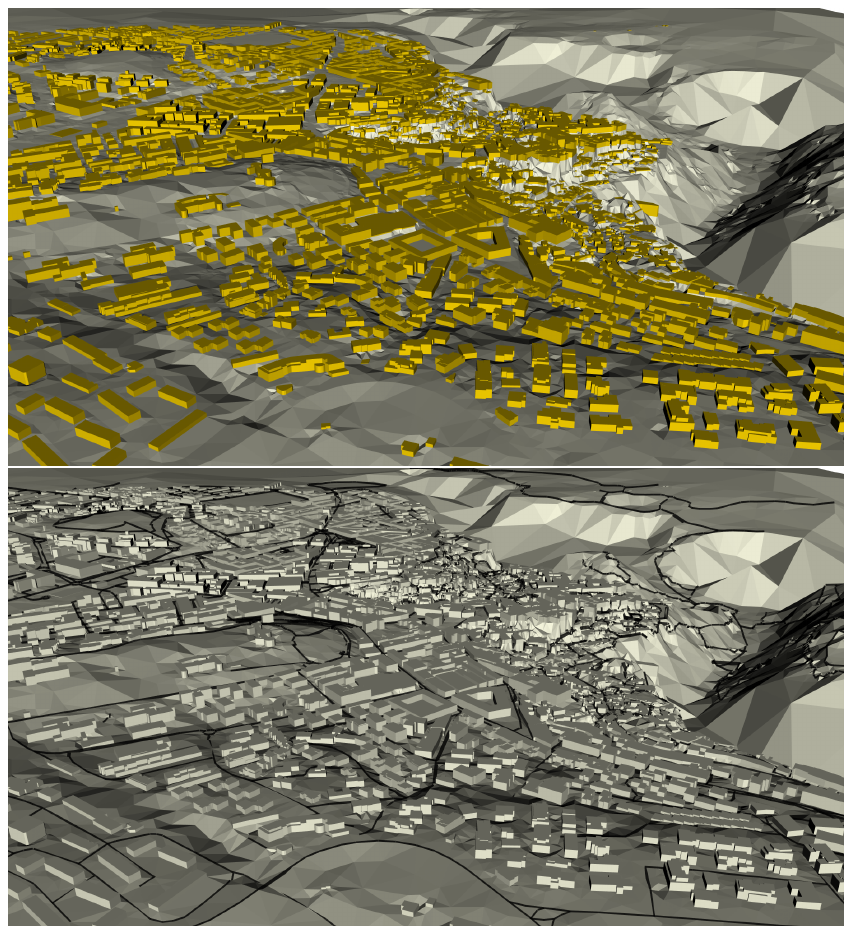
Figure 6. From up to down: the refined 3D model with buildings and the road network highlighted,